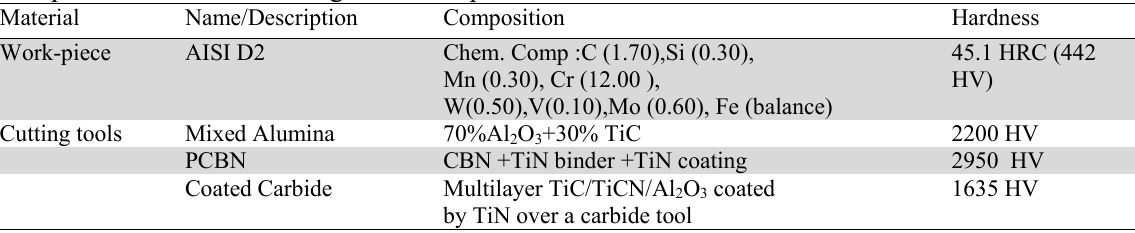
Workpiece material and cutting tool